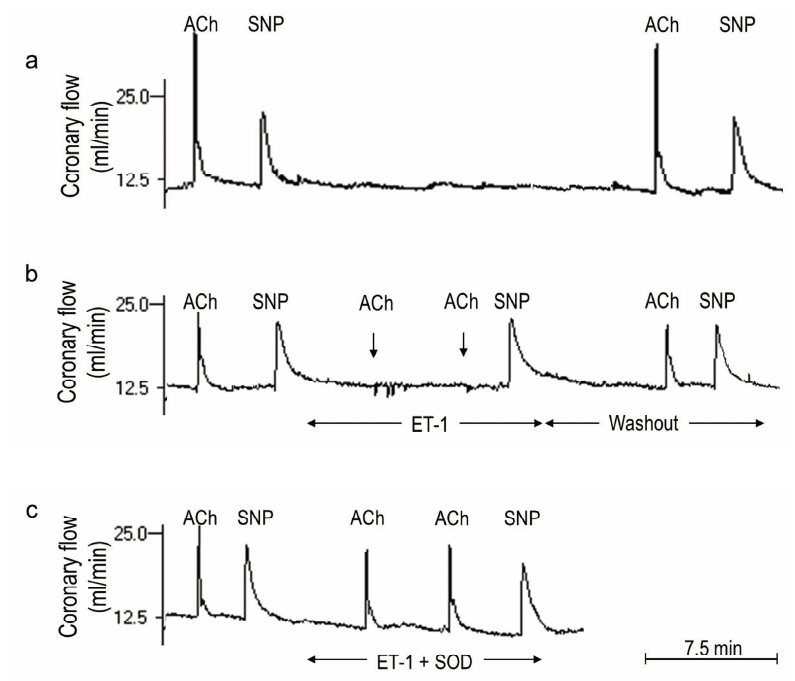
Figure 2. Endothelin-1 (ET-1)-mediated endothelial dysfunction and its prevention by superoxide dismutase (SOD). Shown are three continuous recordings of coronary flow in the Langendorff-perfused guinea pig heart demonstrating responses to boluses of acetylcholine (ACh) and sodium nitroprusside (SNP) in the heart subjected to: ( a ) 35-min control perfusion; ACh and SNP responses obtained at the start and at the end of the perfusion remained unchanged; ( b ) 15-min perfusion with ET-1 (25 pM); ACh and SNP tests were performed before ET-1, in its presence, and after its washout. The response to ACh was completely abolished (see tests at ~5 and ~10 min) and that to SNP remained unaffected in the presence of ET-1, indicating ET-1-mediated endothelial dysfunction. ET-1-washout resulted in an almost complete recovery of the ACh response; ( c ) 15-min of a combined treatment with ET-1 (25 pM) plus SOD (150 IU/mL); SOD completely prevented ET-1-mediated deterioration of the ACh